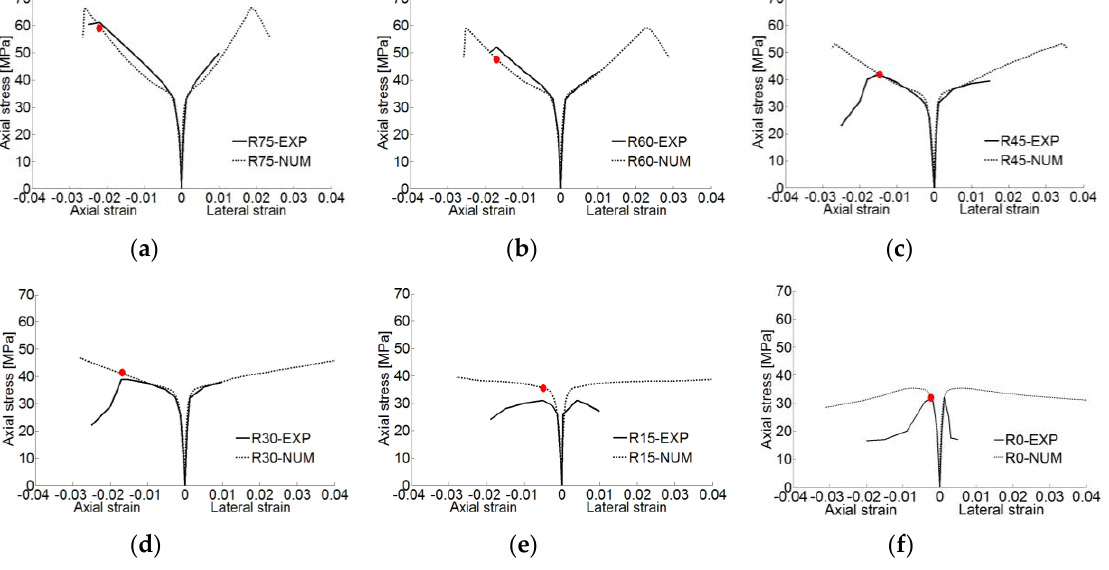
R15, ( f ) R0. ( e ) R15, ( f )